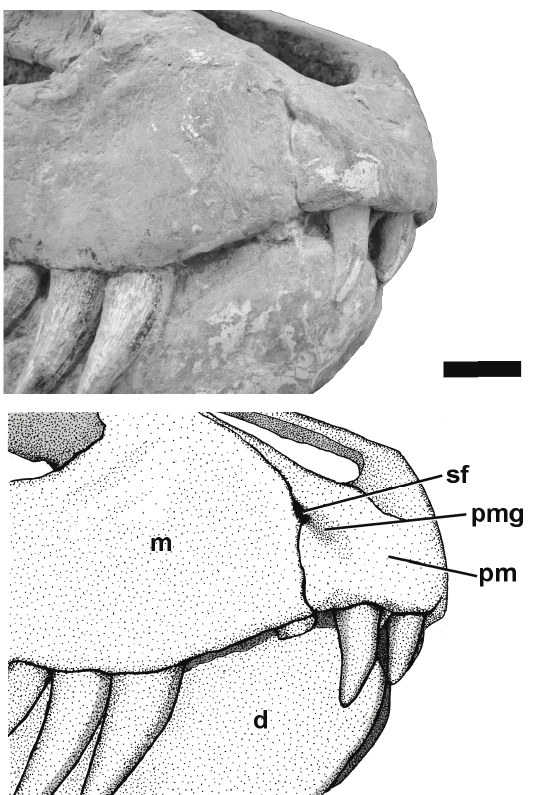
Figure 4 - Photograph and interpretative drawing depicting the rostral region of ULBRA-PVT-281. Abbreviations: d, dentary; mx, maxilla; pmg, premaxillar groove; pmx, premaxilla; sf, subnarial foramen. Scale bar equals 10